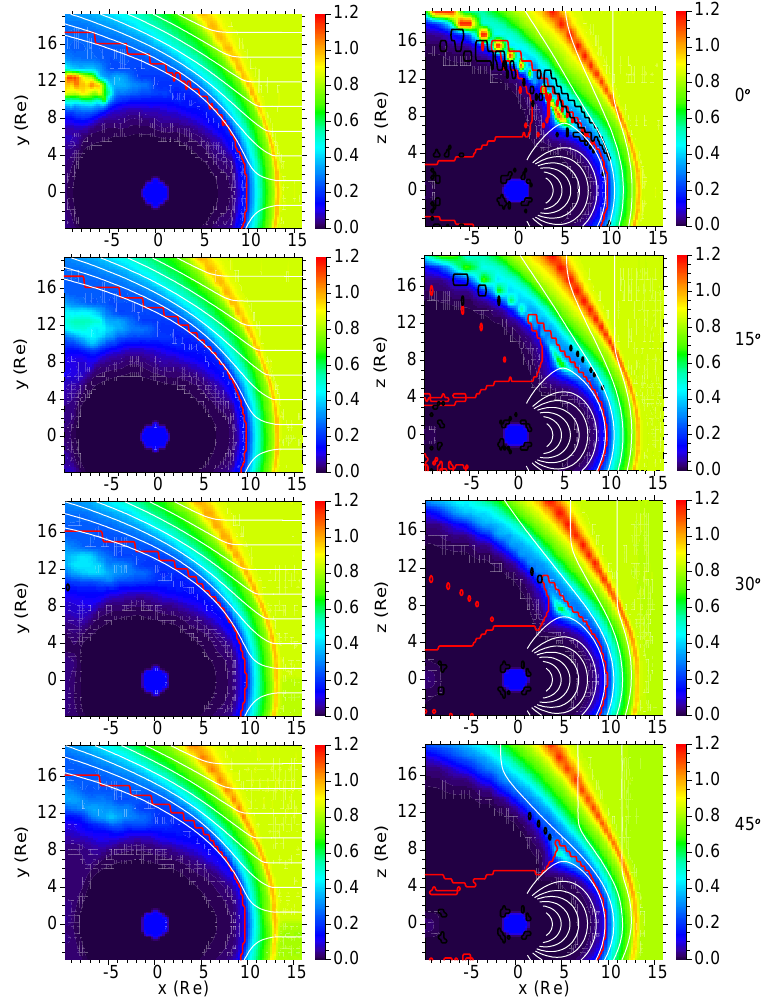
Fig. 9. The dependence of the PDL and the slow mode front on the IMF clock angle: 0 ◦ , 15 ◦ , 30 ◦ , and 45 ◦ with the same IMF magnetic field magnitude (7nT). The other solar wind input parameters are: V =( − 450, 0, 0)km/s, N=6cm − 3 , and T p =T e =10eV. The other formats of this figure are the same as those in Fig.